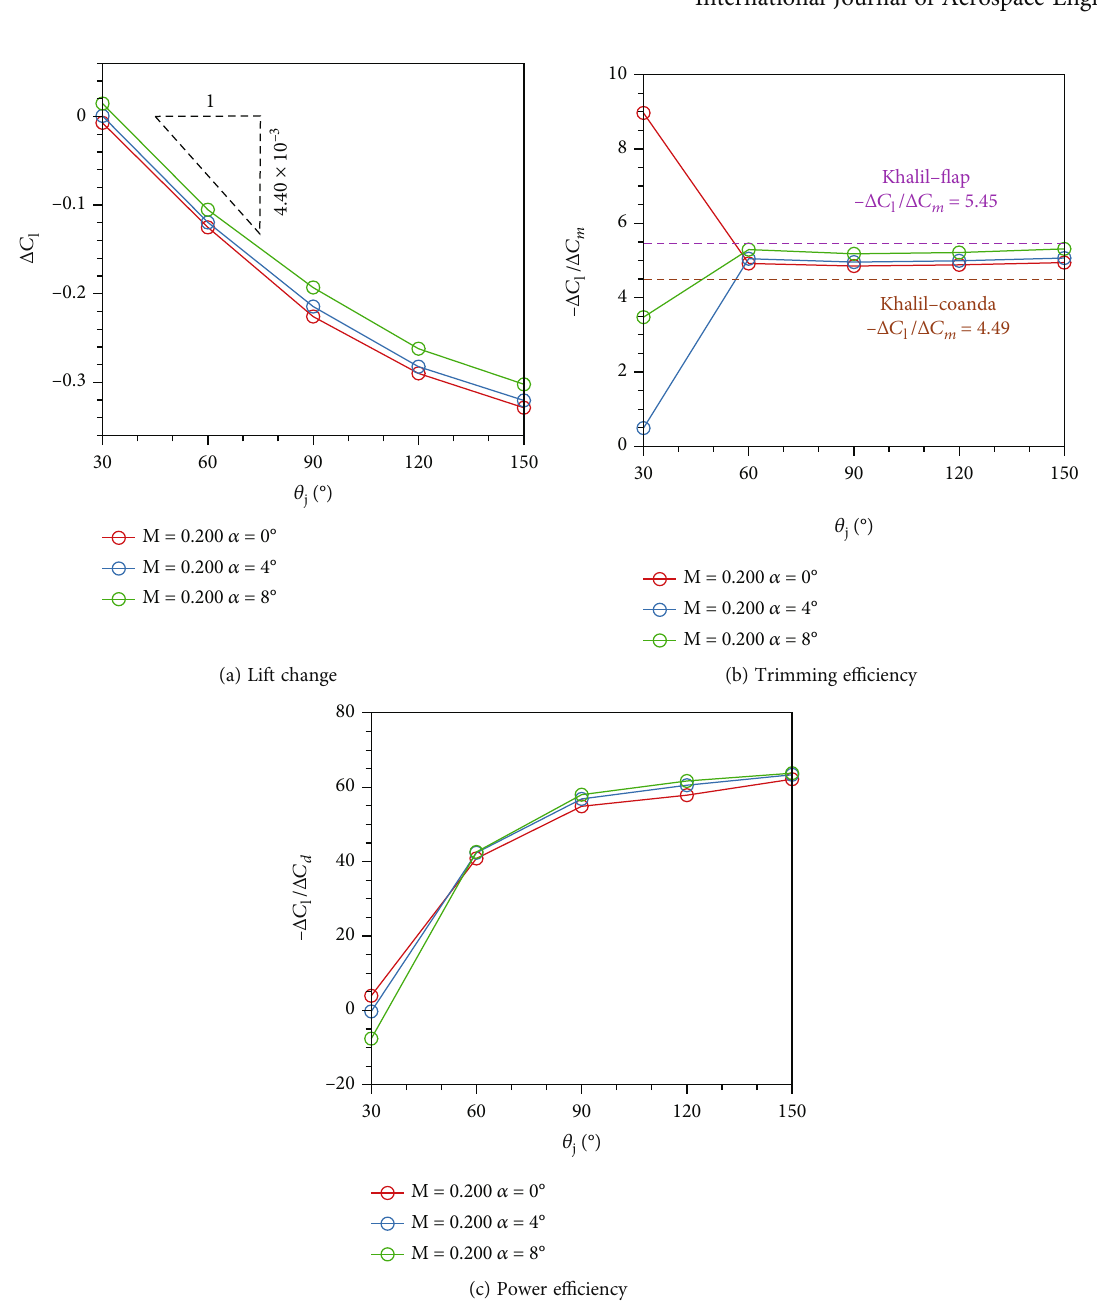
Figure 9: Subsonic control e ffi ciencies with steady blowing at M